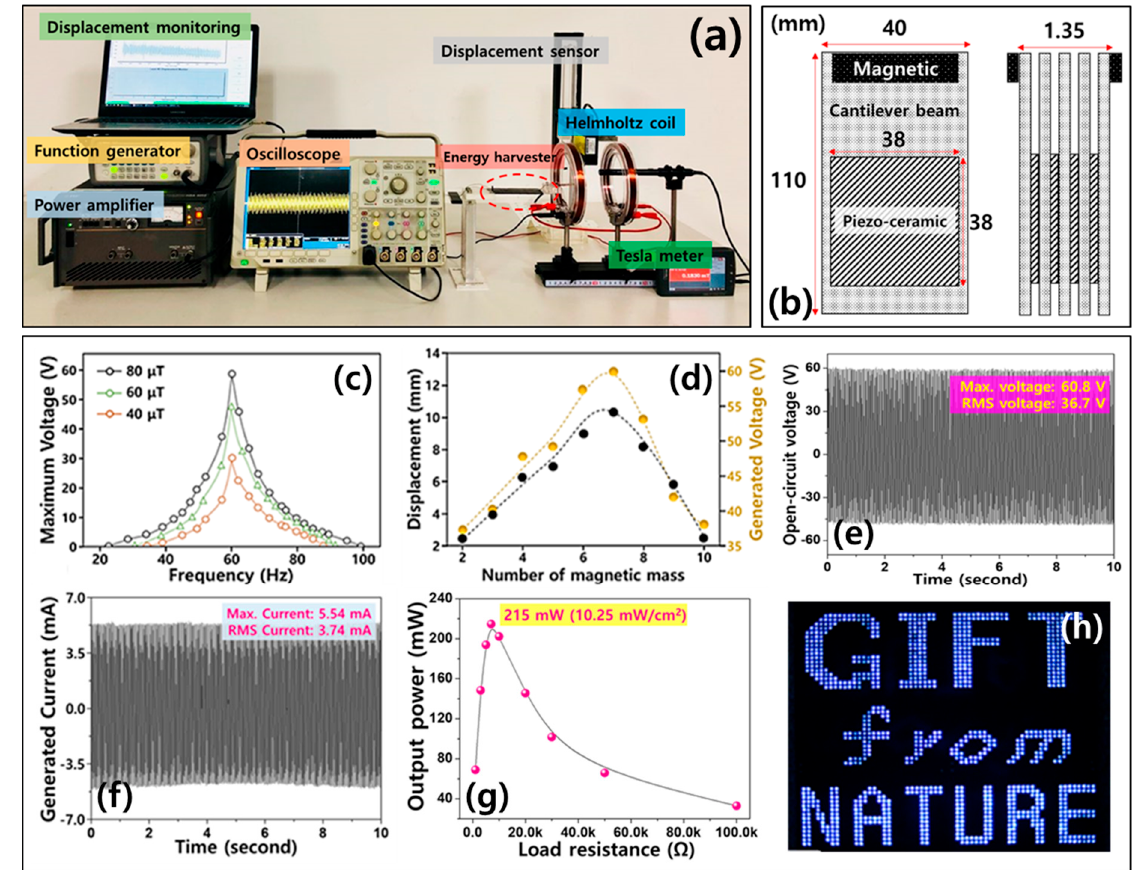
Figure 4. ( a ) Experimental apparatus for harvesting electric energy by adjusting magnetic field and frequency. ( b ) Harvester used in the experiment and size in detail. ( c ) Maximum voltage of harvester depending on the magnetic field and frequency. ( d ) Displacement and output voltage depending on the magnetic mass of harvester. ( e ) Open-circuit voltage generated from ×4 harvesters under an AC magnetic field of 80 μ T at 60 Hz for 10 s. ( f ) Generated current generated from ×4 harvesters under an AC magnetic field of 80 μ T at 60 Hz for 10 s. ( g ) Output power depending on load resistances. ( h ) We utilized electricity generated from the ×4 harvester to illuminate 972 LEDs.